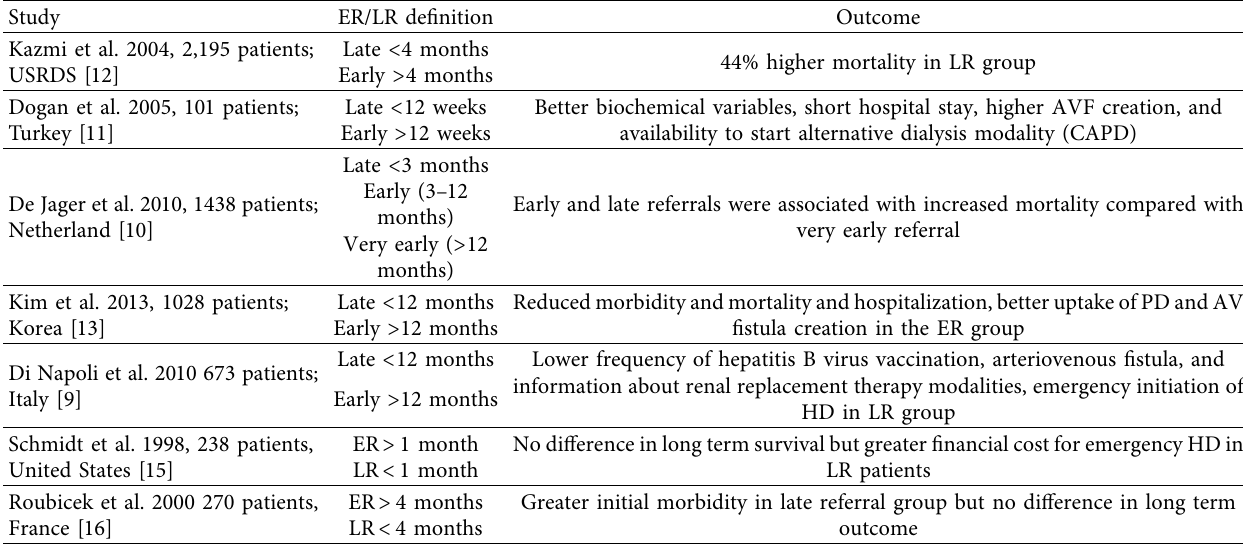
Table 8: Summary of the studies with outcomes in the early versus late